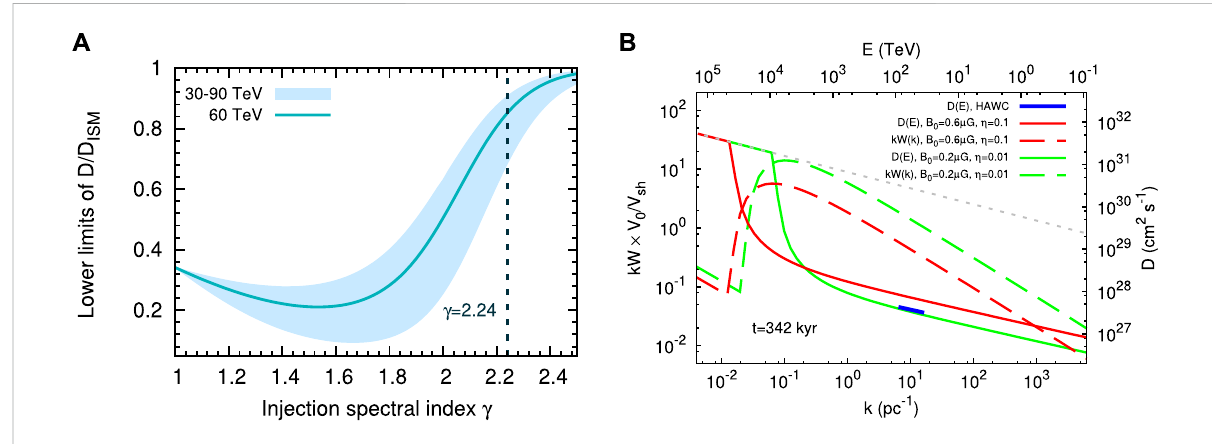
FIGURE 2 (A) : Lower limit of the diffusion coef fi cient in the Geminga halo as a function of the injection spectral index under the self-generated scenario. The RSI is assumed to account for the turbulent growth. One-dimensional diffusion is assumed. Energy losses of electrons and turbulent damping are ignored, which are optimistic conditions for turbulent growth. Electrons injected during the last third of the age of Geminga are all assumed to contribute to the turbulent growth. (B) Wave-number spectrum of the MHD turbulence and the corresponding diffusion coef fi cient for the Geminga halo, assuming the turbulence is provided by the SNR shock. B 0 is the background magnetic fi eld strength, and η is the conversion ef fi ciency from the SNR initial energy to the MHD turbulenct energy. The gray dotted line is the average diffusion coef fi cient in the Galaxy. Both fi gures are taken from Fang et al.